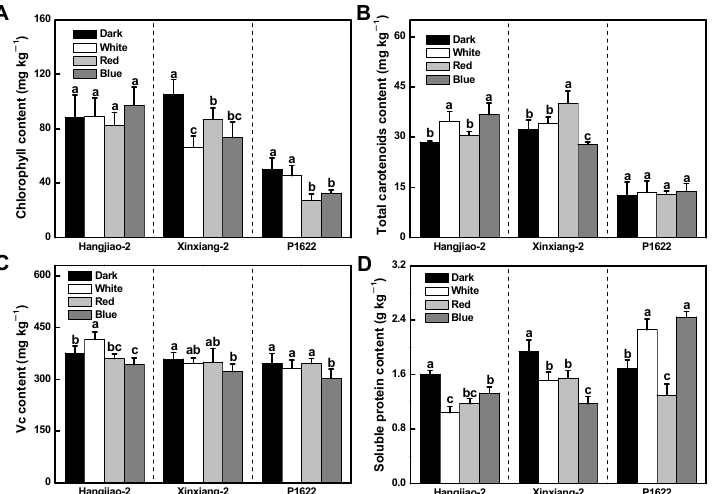
Figure 3. Effect of light quality on chlorophyll content ( A ), total carotenoid content ( B ), vitamin C content ( C ), and soluble protein content ( D ). Results are shown as mean ± SE of triplicate samples. Means denoted by the same letter were not significantly different at p < 0.05 according to Tukey’s